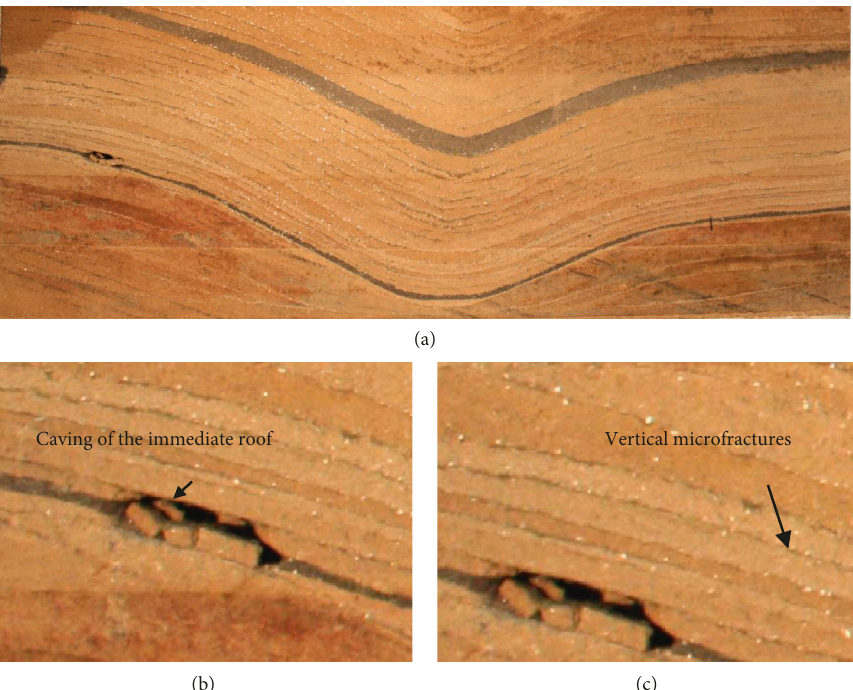
Figure 4: First caving of the immediate roof. (a) State before the roof collapses. (b) Caving of the immediate roof. (c) Vertical microfractures development.